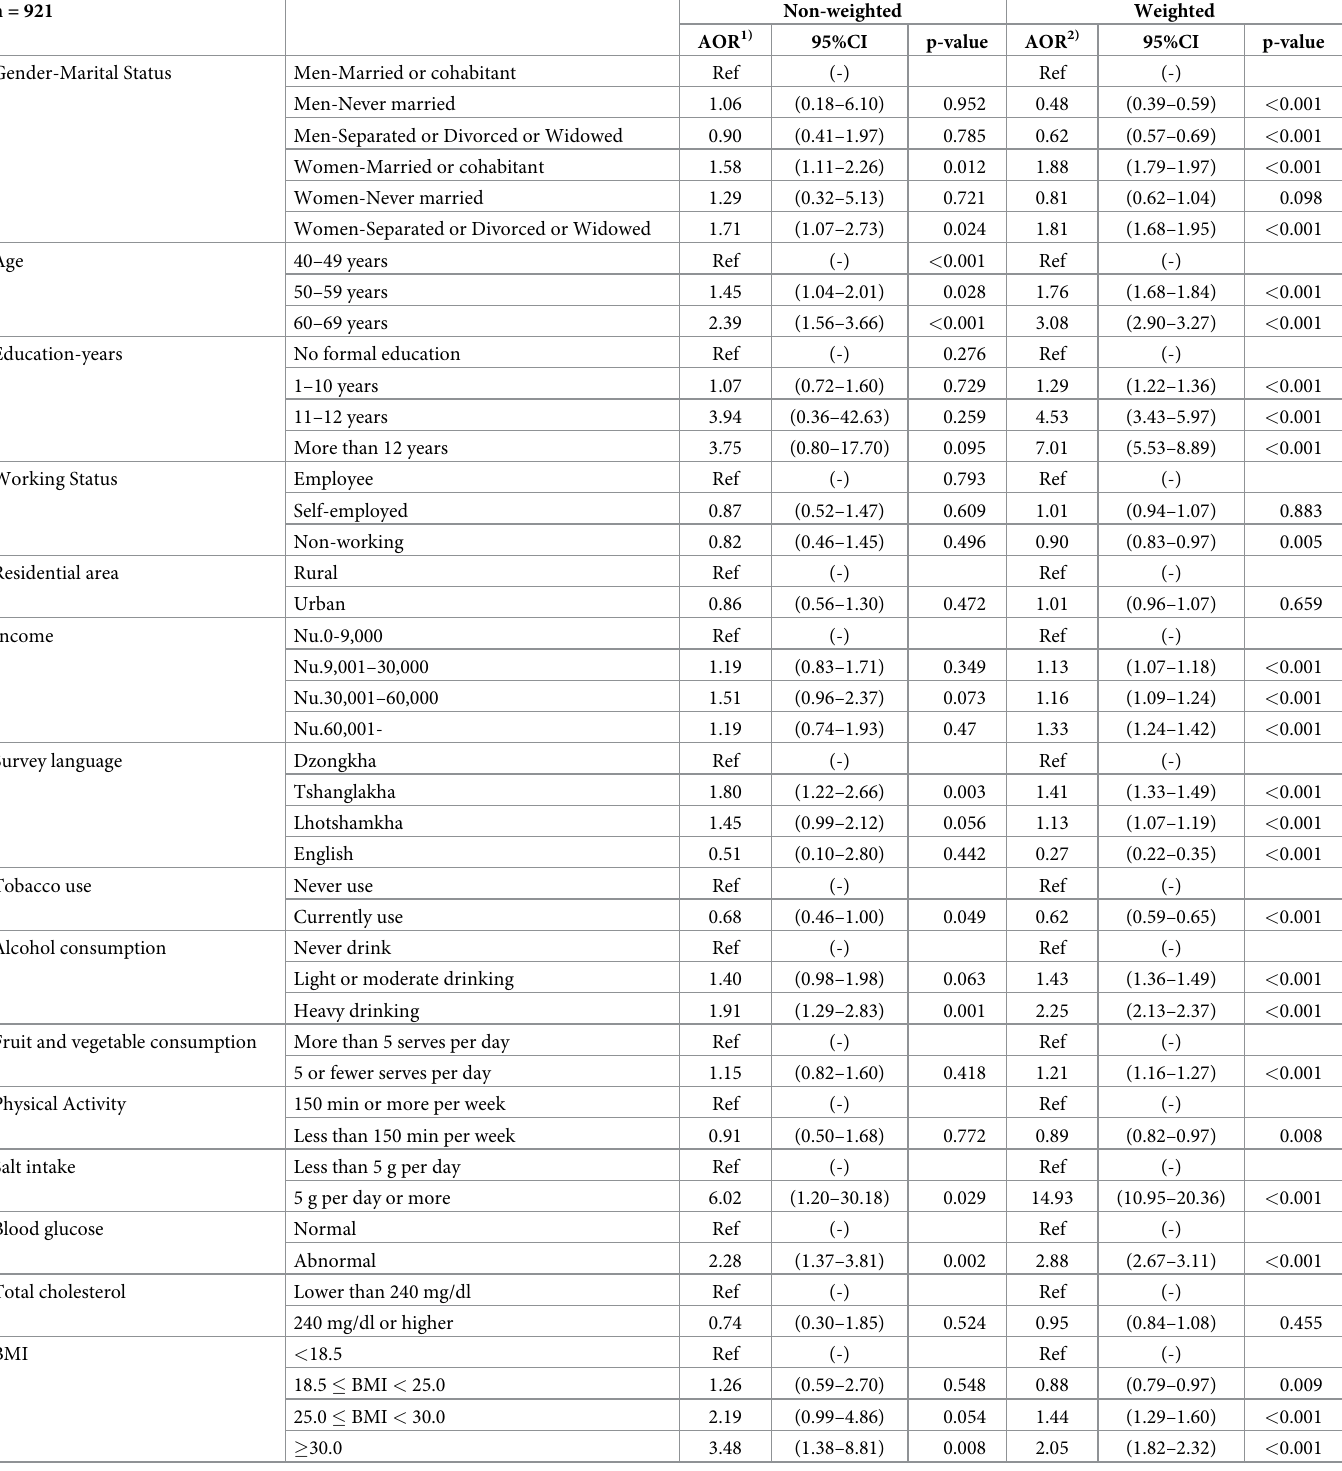
Table 4. Multivariable logistic regression analysis for hypertension with sociocultural, lifestyle, biomedical, and mental health variables for participants aged 40 years or more. n =